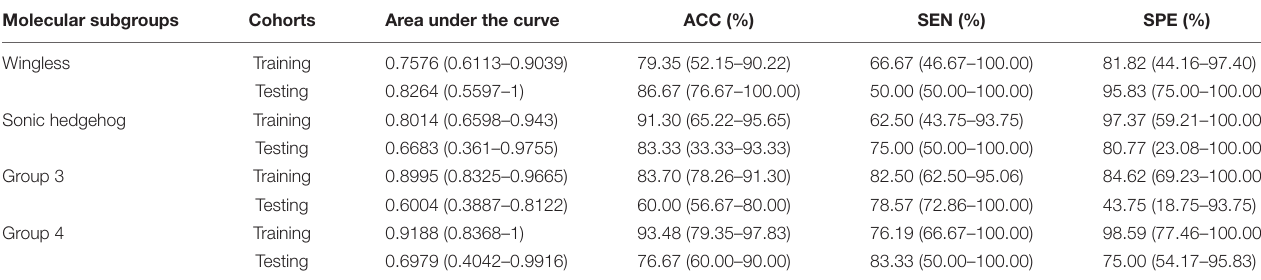
TABLE 3 | Summary of the subgroup-specific classification performance of the radiomics model. Molecular subgroups